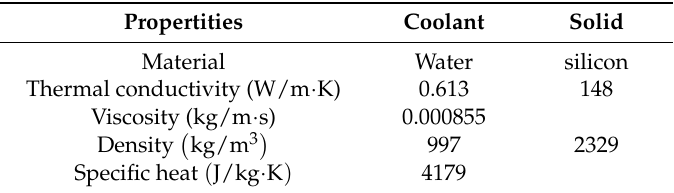
Table 1. Material properties of the coolant and heat sink.